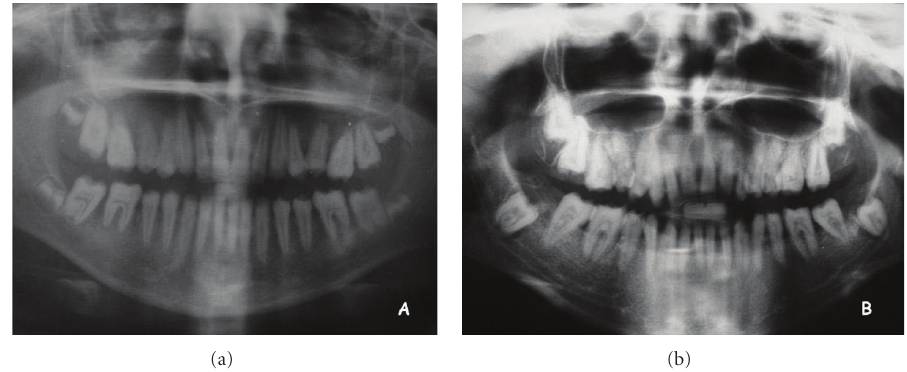
Figure 3: Panoramic radiography shows reduction of enamel thickness for younger (a) and older (b) patients.